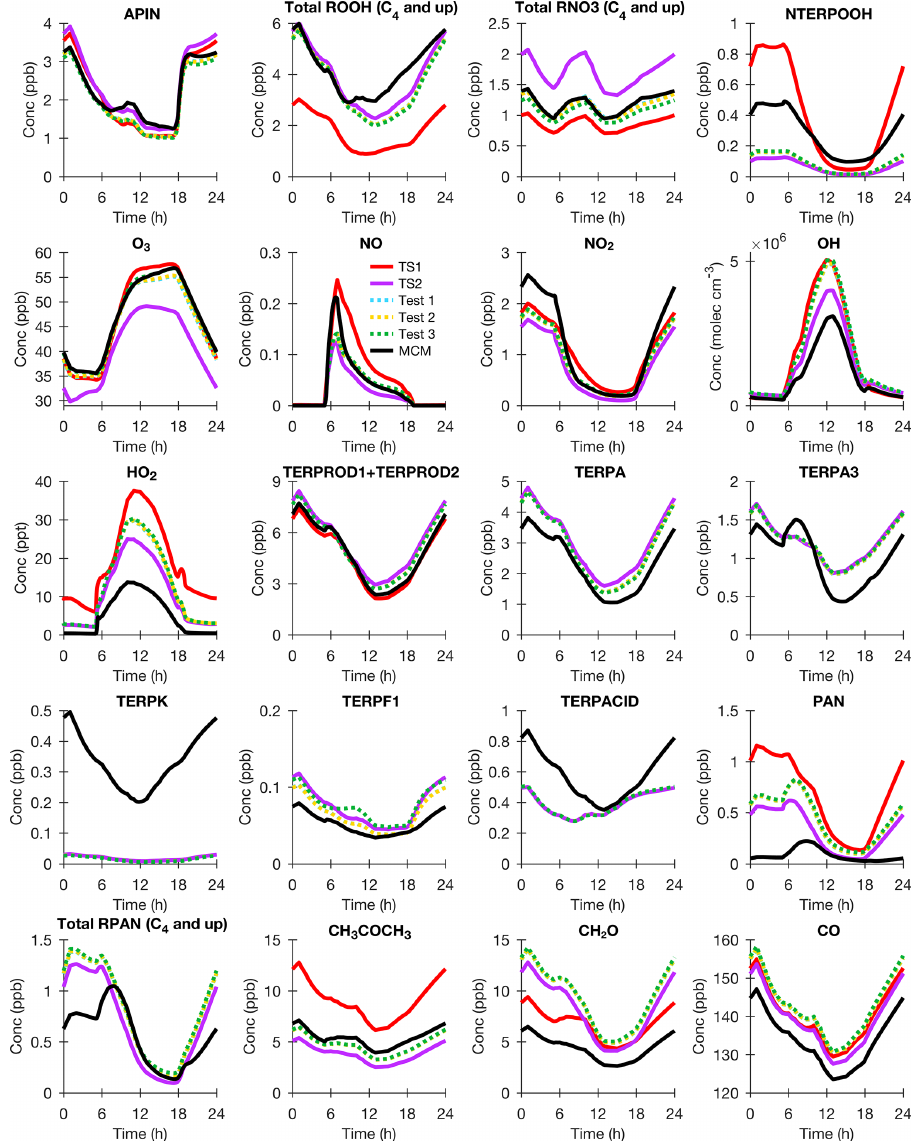
Figure 4. BOXMOX results for α -pinene (APIN) oxidation using TS1 (red), MCM (black), TS2 (purple), TS2 with MCM pinonaldehyde nitrate yield (blue; Test 1), TS2 with MCM pinonaldehyde and limonaldehyde nitrate yield (gold; Test 2), and TS2 with MCM pinonaldehyde and limonaldehyde nitrate yield and assumptions for oxidation of unsaturated hydroxy nitrates (green; Test 3). The model configuration is explained in Sect. 3.1. APIN ( α -pinene surrogate), TERPOOH (terpene hydroxy hydroperoxide), total ROOH (all terpene hydroperoxides C